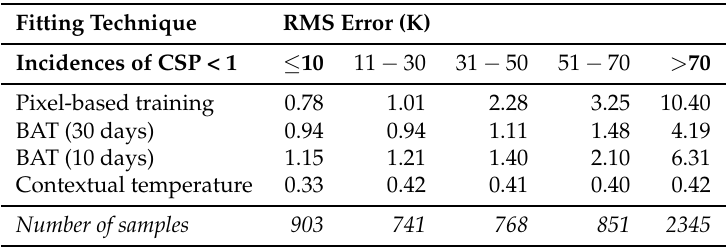
Table 2. Comparison of fitting techniques to brightness temperatures recorded by the AHI sensor using root mean square error after eliminating incidences of Clear Sky Probability (CSP) of less than one from the evaluation.